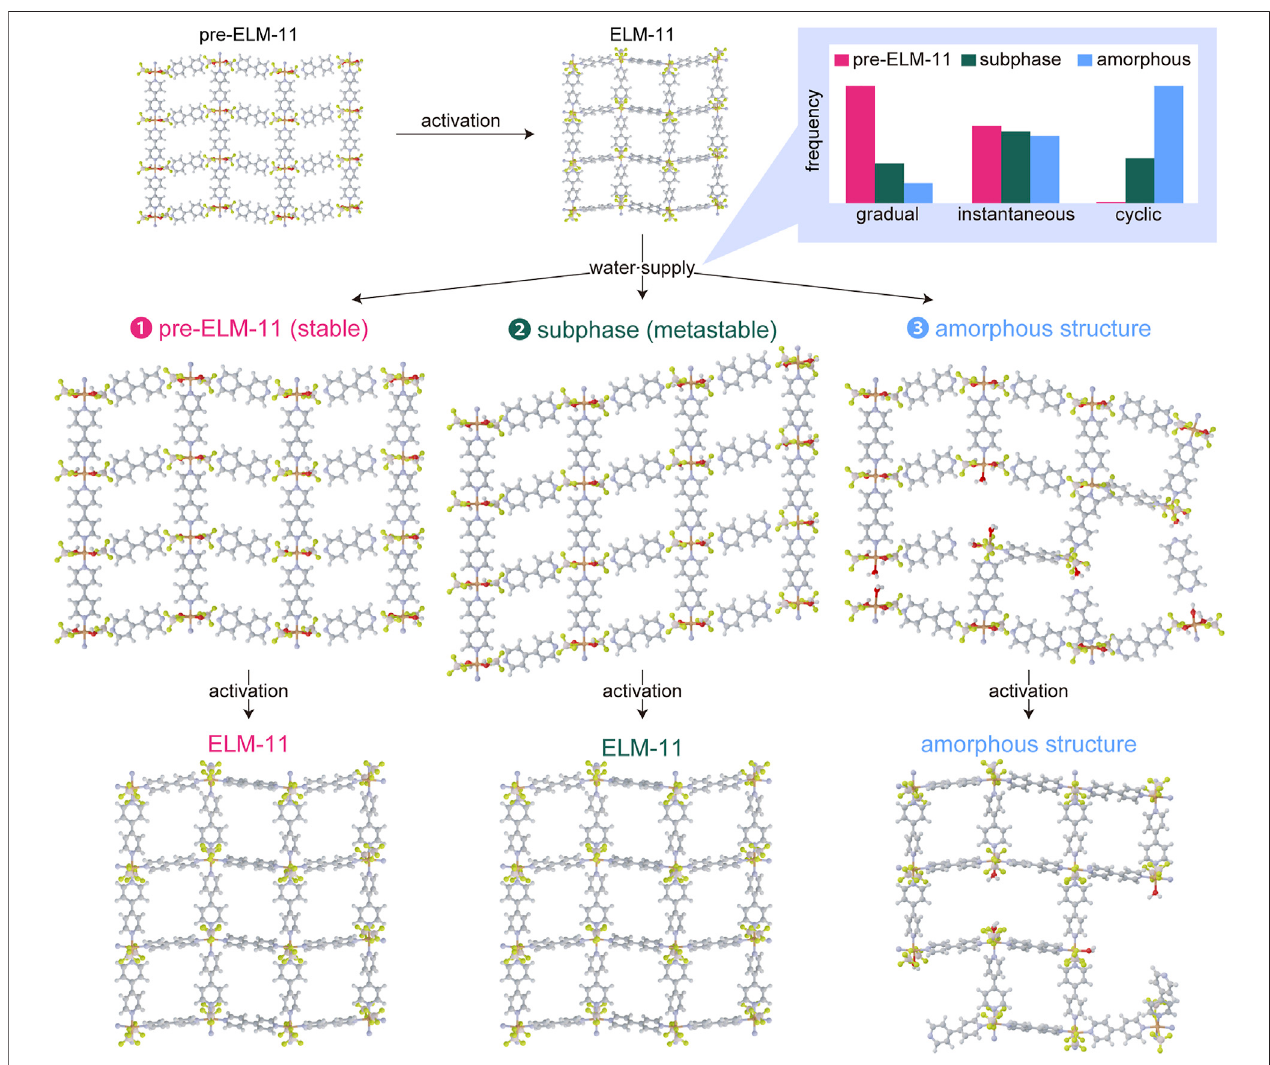
FIGURE 5 | Schematic of proposed mechanism.